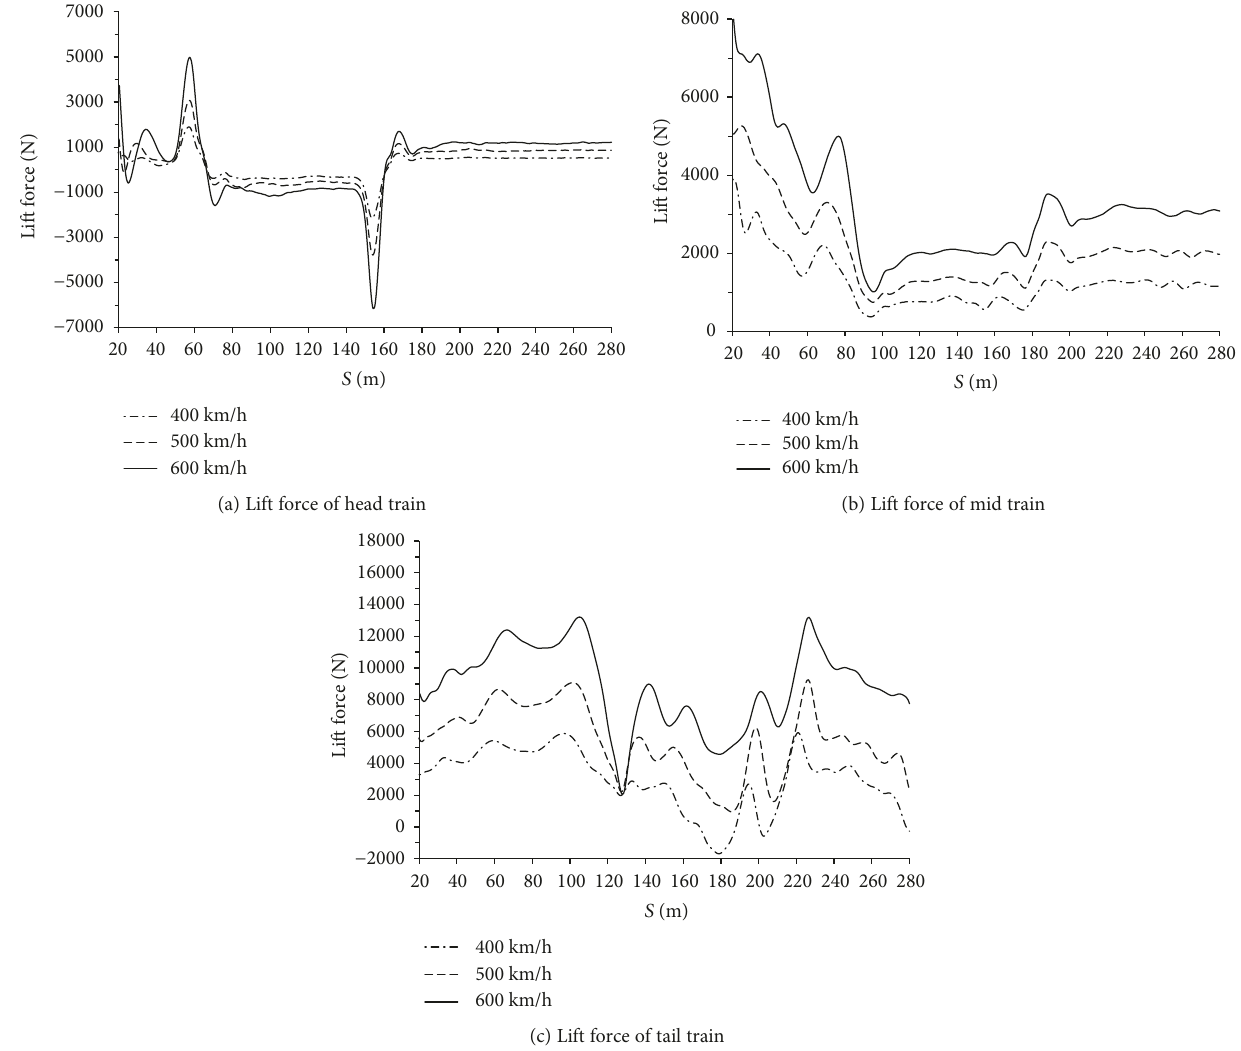
Figure 16: Changing of aerodynamic lift force of each train